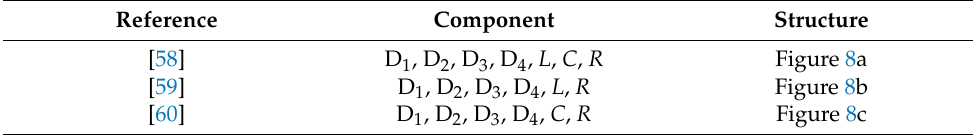
Table 5. Memristive diode rectifier